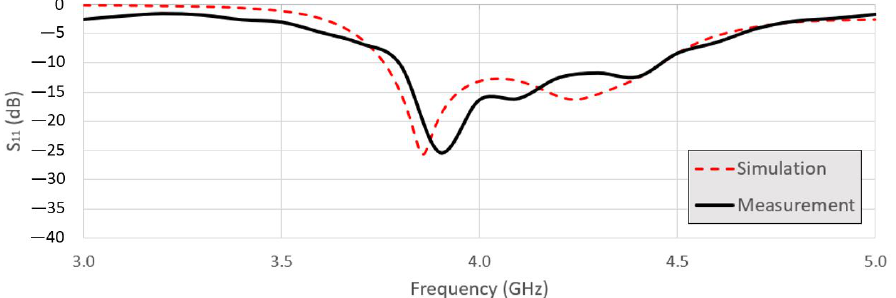
Figure 3. Simulated and measured reflection coefficient.